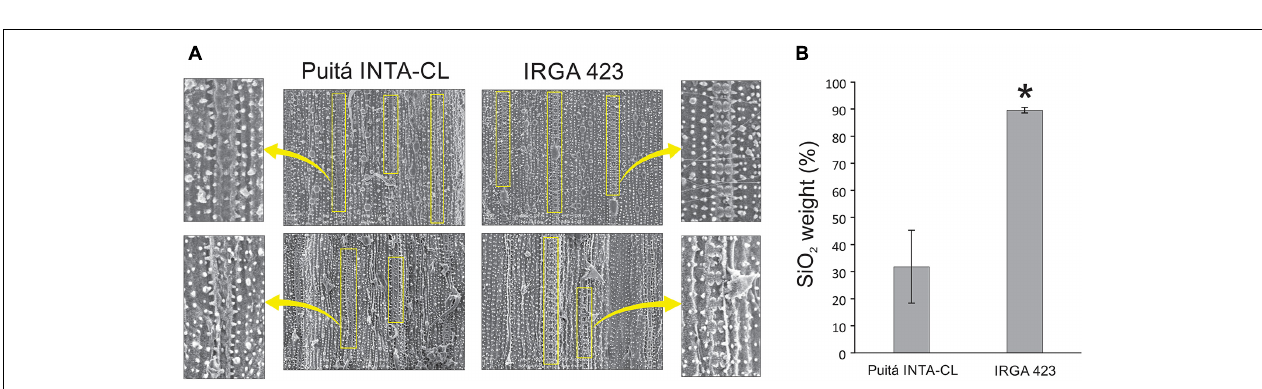
FIGURE 6 | Histochemical staining assay (A) of H 2 O 2 and loss of plasma membrane integrity (indicative of cell death), by DAB and Evans Blue, respectively, in control and LI leaves of the two tested cultivars (Puitá INTA-CL and IRGA 423). The positive staining (detected in higher levels on infested leaves) in the photomicrographs shows as bright images (brown-color for DAB and blue-color for Evans Blue). Bars in figures indicate 0.5 cm. Total phenolic compounds (B) of control and EI leaves of the two tested cultivars (Puitá INTA-CL and IRGA 423). Represented values are the averages of three samples ± SE. Different letters indicate that the means are different by the Tukey’s HSD test ( P ≤ 0.05). GAE, gallic acid equivalents; DW, dry weight.